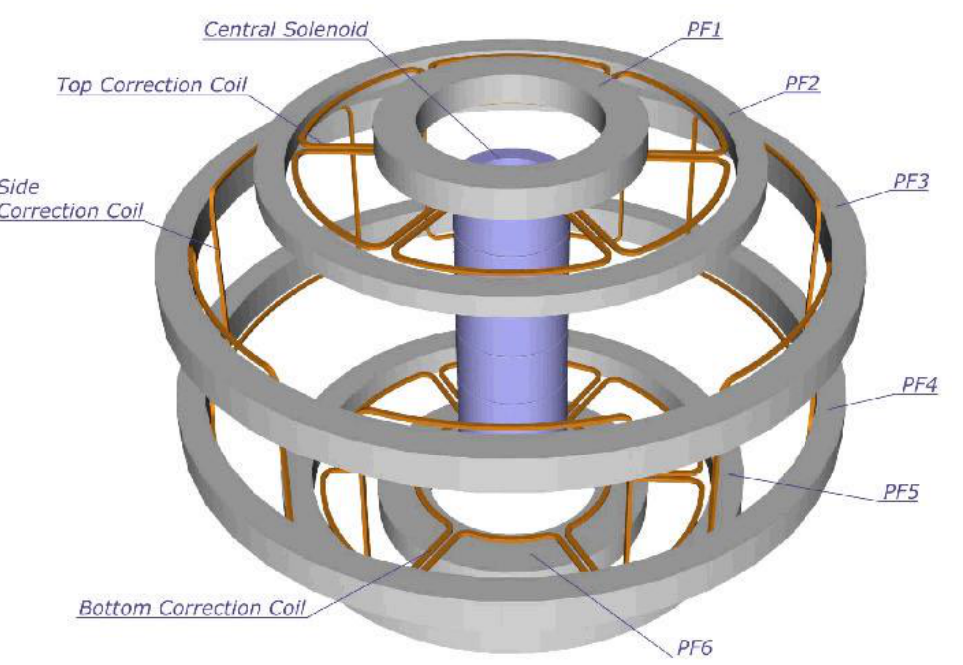
Figure 5. Correction coil arrangement in the ITER Tokamak (PF coils and error field correction coils (from ITER Technical Basis [4]). ©2002 IAEA.